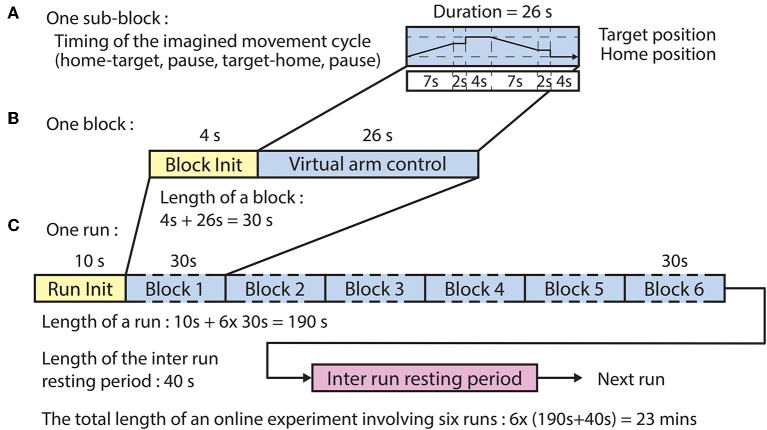
Timing of the online paradigm. (A) Timing of the virtual arm control between the home position and one of the three corresponding target positions. The imagined movement cycle comprised home-to-target movement (7 s), pause [at movement end-point (2 s) + at target (4 s)], target-to-home movement (7 s), and pause [at movement end-point (2 s) + at home (4 s)] intervals. (B) A block comprised a block initialization period and an imagined movement cycle. (C) A run comprised a run initialization period and six blocks corresponding to the six targets in random order (the six targets comprised three targets per arm).